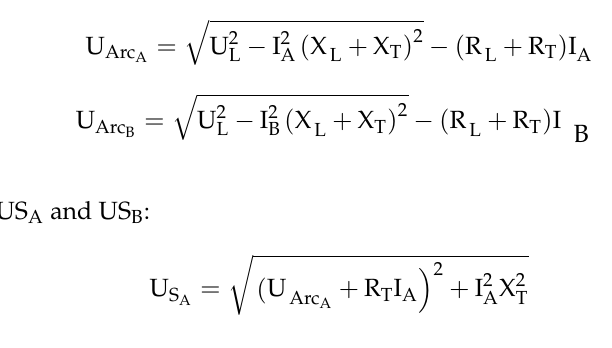
and voltages US A and US B